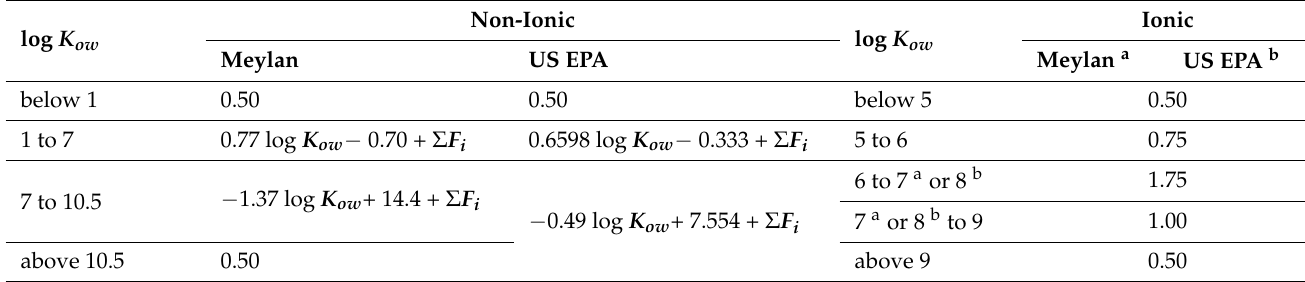
Table 1. log BCF vs. log K ow according to Meylan ( a ) and US EPA ( b )